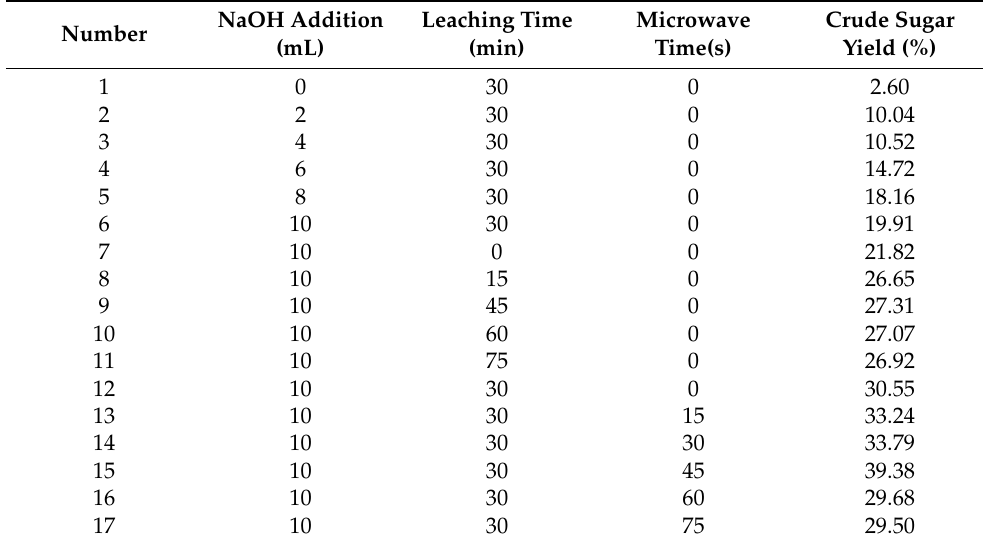
Table 2. Crude sugar yield response surface design and results.